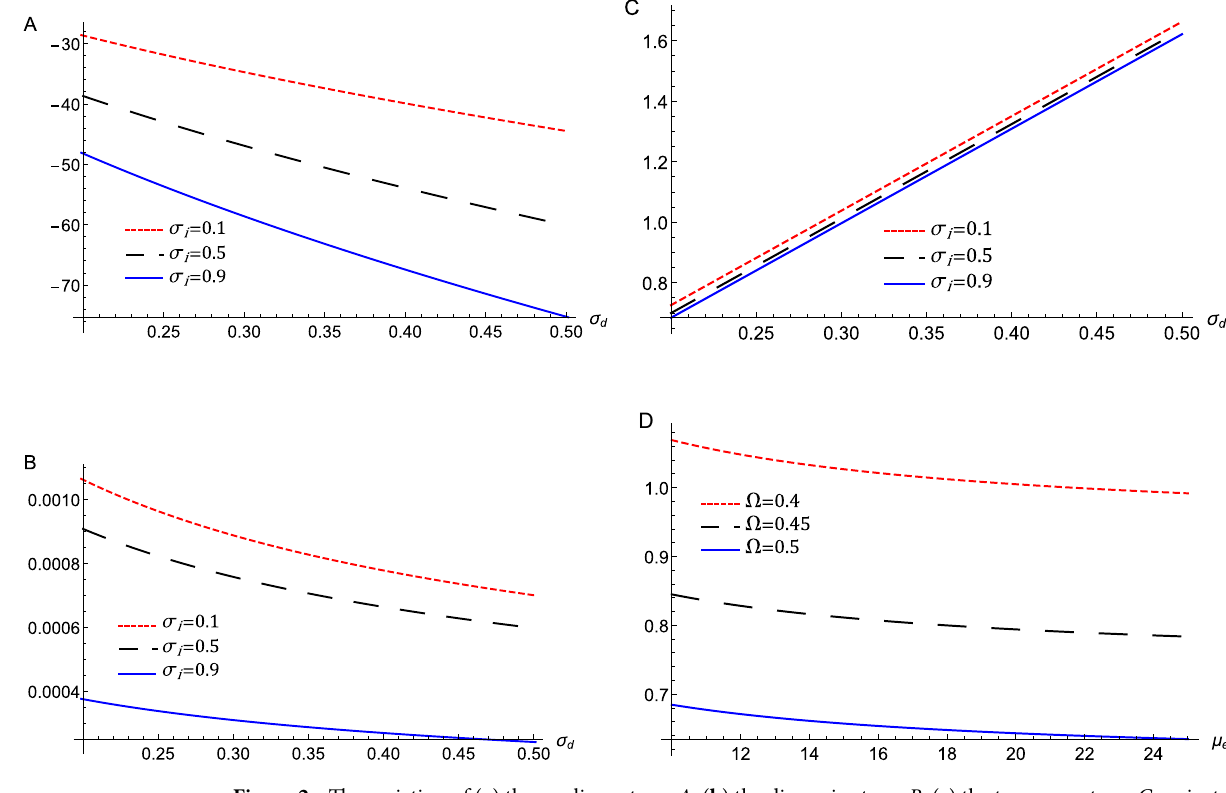
Figure 2. The variation of ( a ) the nonlinear term A , ( b ) the dispersive term B , ( c ) the transverse term C against σ d for different values of σ i , at µ e = 18 , and ( d ) the transverse term C against µ e for different values of (cid:31) at σ i = 0.5 , and σ d = 0.3 that are represented by Eq.